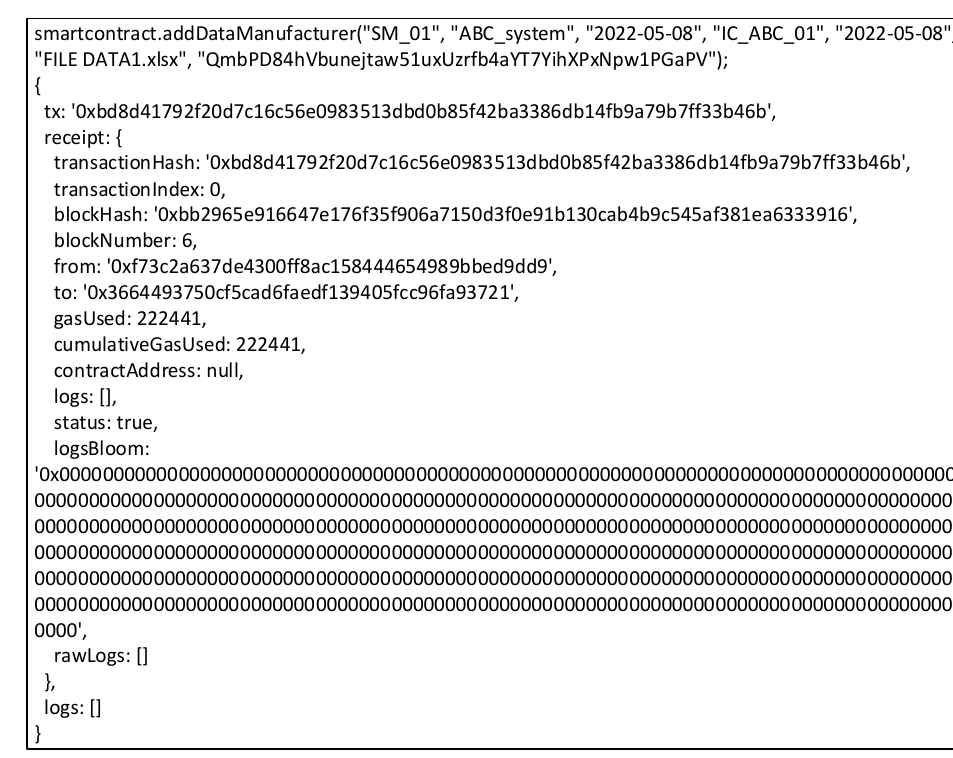
Figure 10. Example of transaction